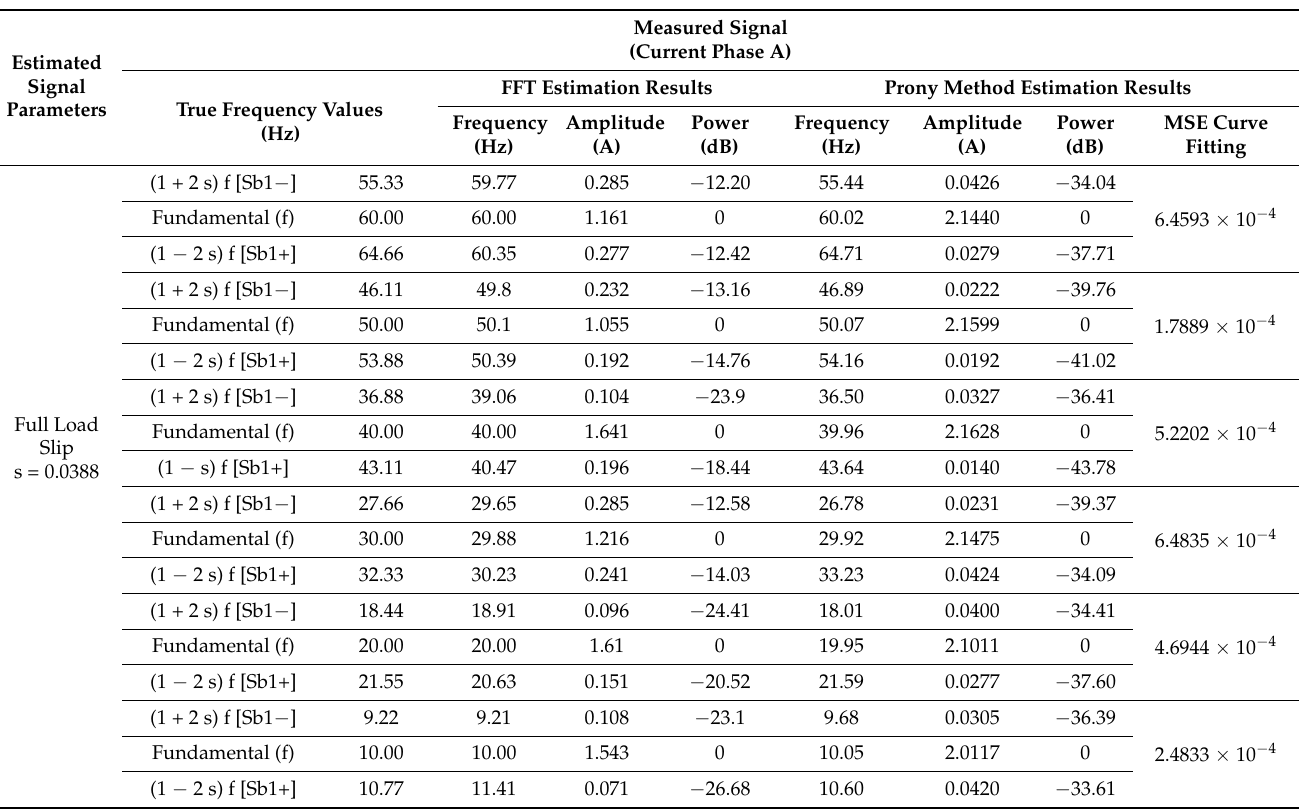
Table 8. Summary of current signal estimated parameters using FFT and Prony method (VFD, motor at full